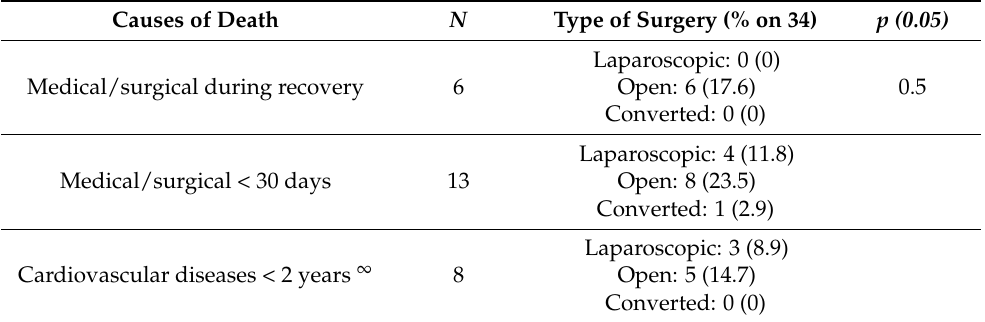
Table 3. Causes of death (N), type of surgery, % on total deaths (% on 34), and p (0.05). Causes of